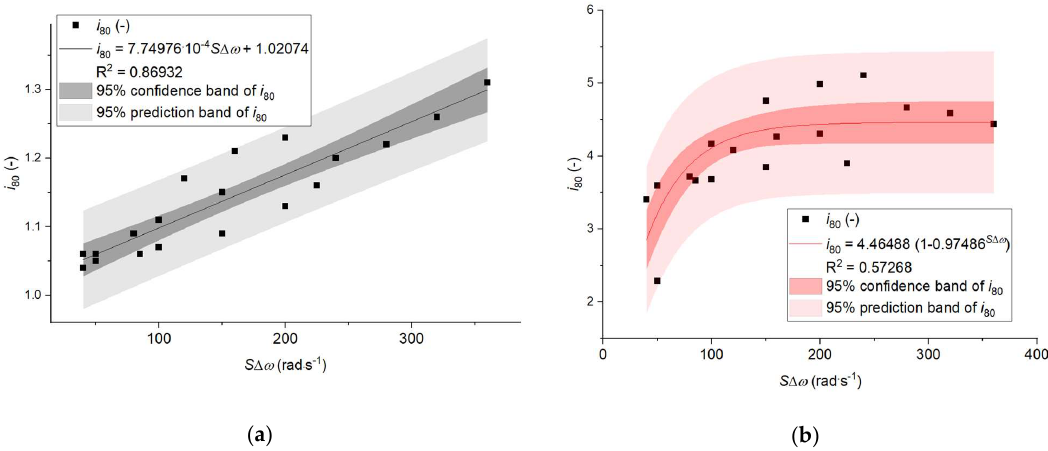
Figure 10. An 80% fragmentation degree as a function of the total speed increase with the markings of the confidence interval and values predicted for: ( a ) rice grain comminution and ( b ) corn grain comminution.